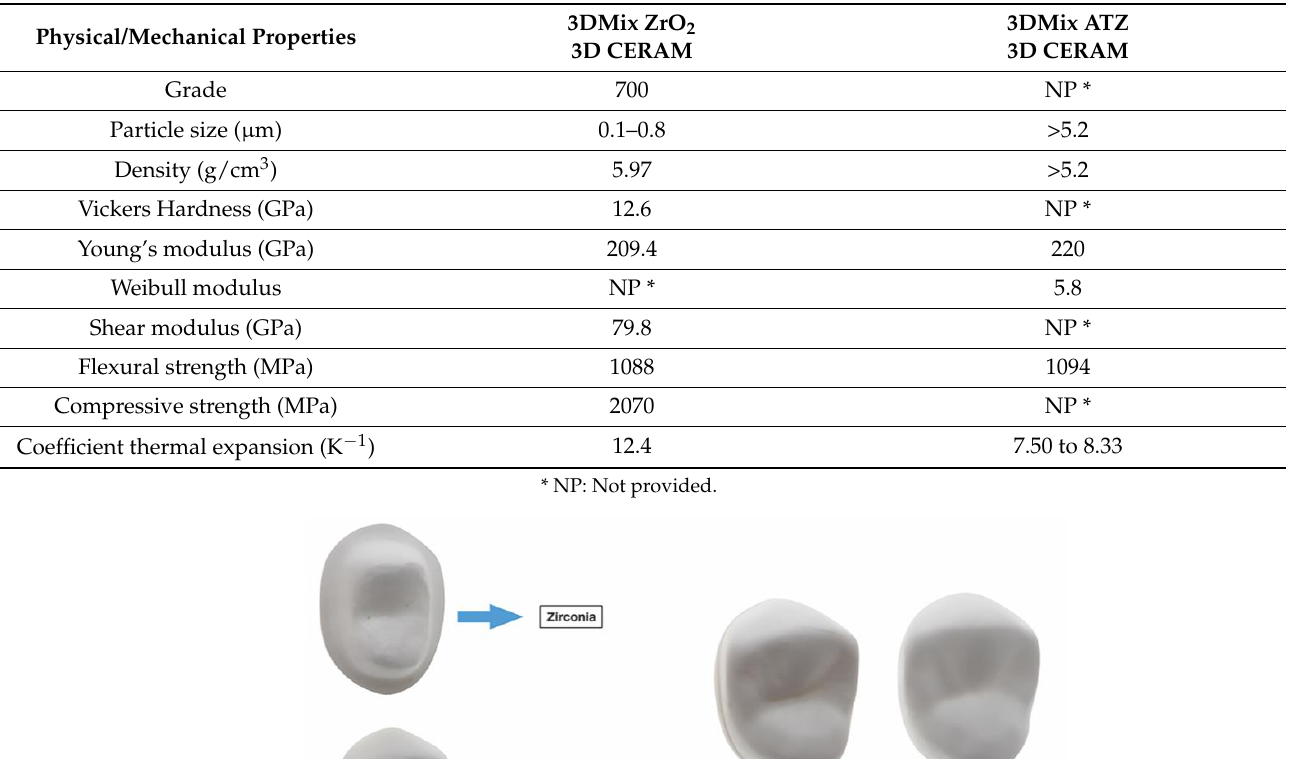
Figure 3. STL 2 file split in top and bottom layers. Table 1. Physical and mechanical properties of additive manufactured zirconia and alumina toughened zirconia material. Information provided by the manufacturer.